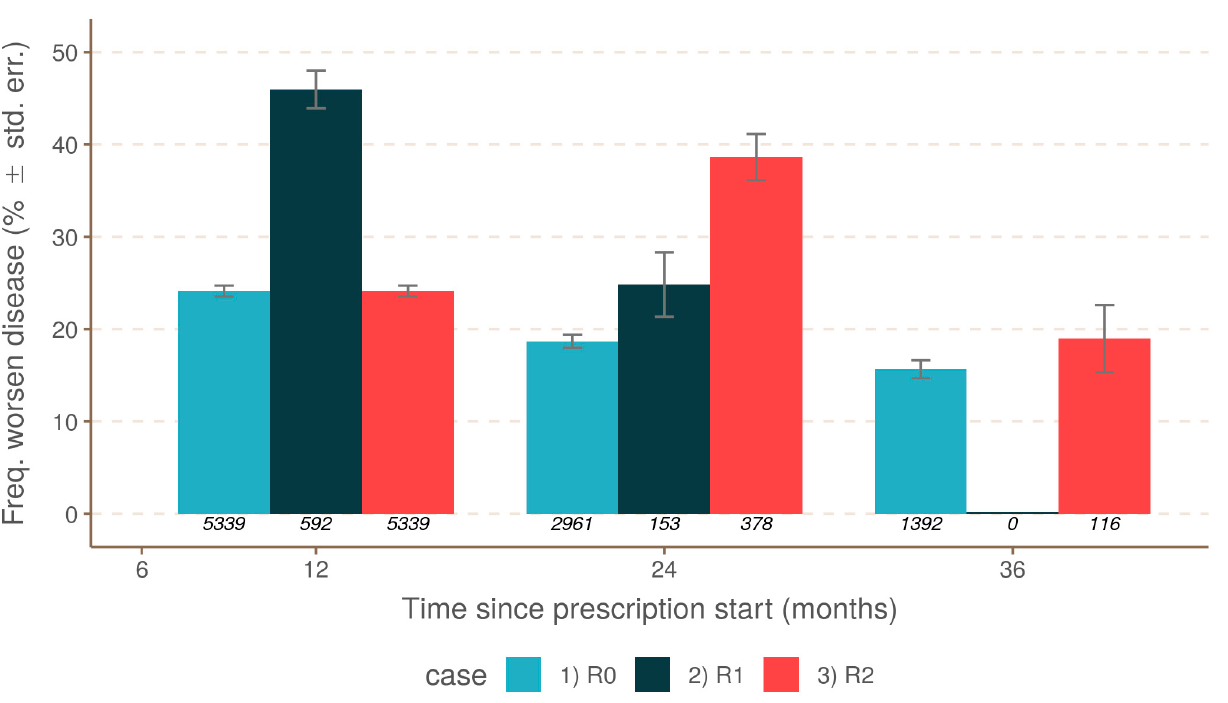
Figure 3. Comparison between disease worsening and three scenarios: R0 (no relapse), R1 (relapse during the first year), and R2 (relapse during the second year).